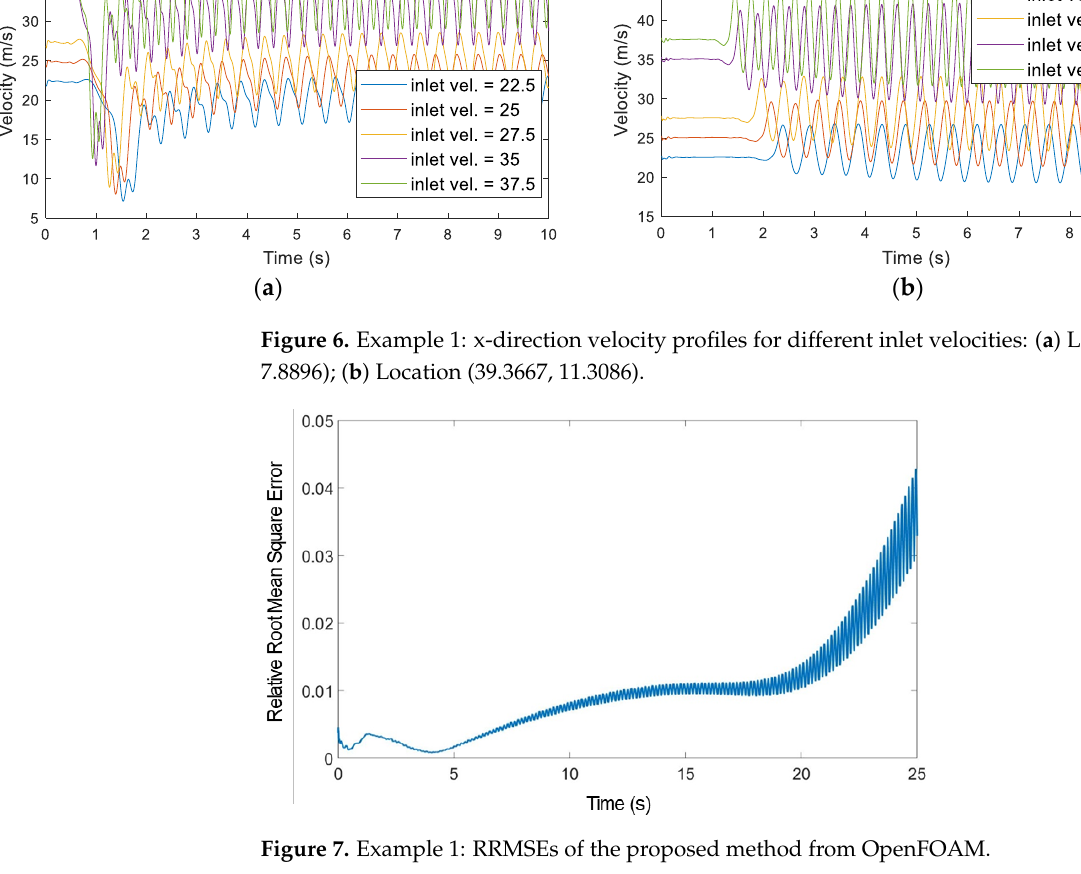
Figure 6. Example 1: x-direction velocity profiles for different inlet velocities: ( a ) Location (20.9761, 7.8896); ( b ) Location (39.3667, 11.3086).